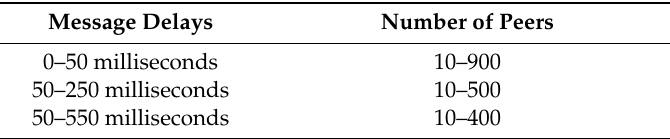
Table 1. Number of peers and